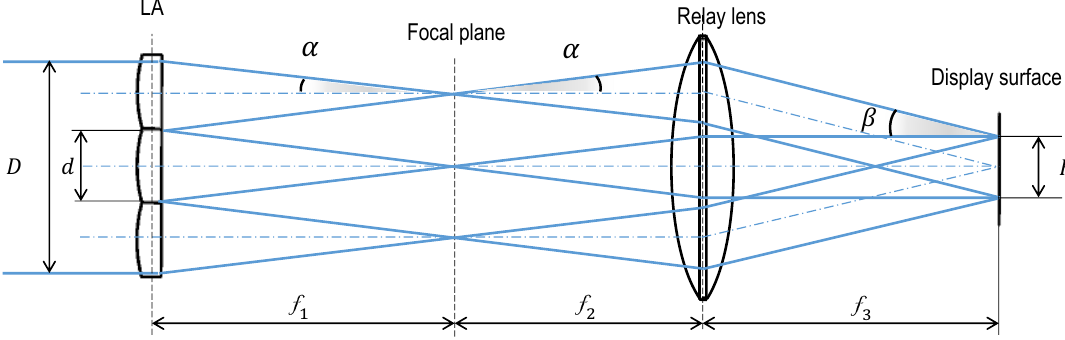
Figure 3. Working principle illustration of a lenslet array (LA) homogenizer, the LA is composed of three